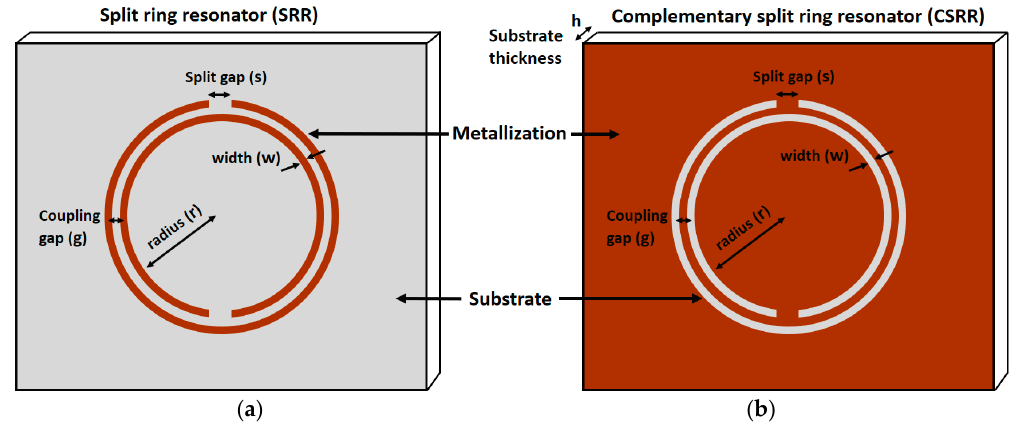
Figure 1. Metamaterial (unit cell) Topologies: ( a ) split ring resonator (SRR); and ( b ) complementary split ring resonator (CSRR).